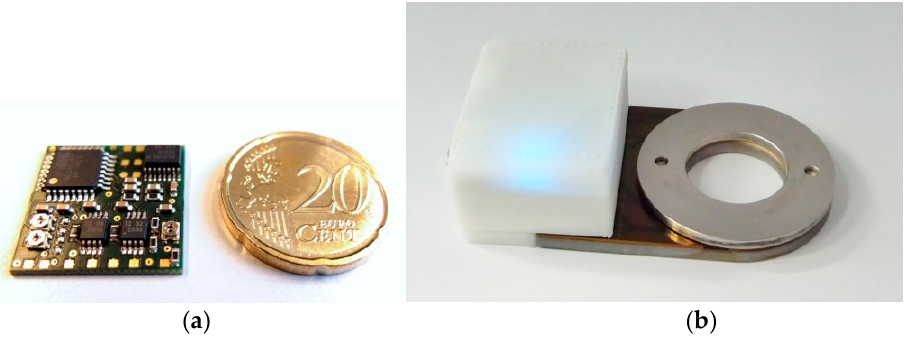
Figure 3. ( a ) Measuring circuit with amplification, filtering and digitizing as well as a digital processing and data transmission via Bluetooth Low Energy; ( b ) washer sensor with electrical measuring and data transmission circuit inside the attached